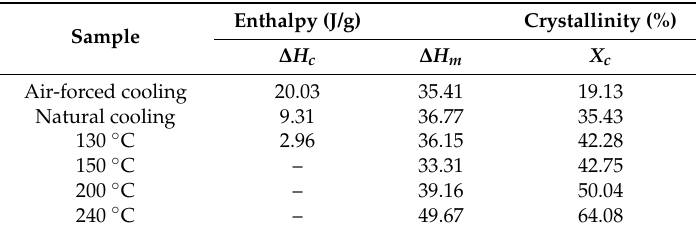
Figure 5. DSC curves of 3D-printed PPS samples. Table 2. Thermal properties of 3D-printed PPS samples.